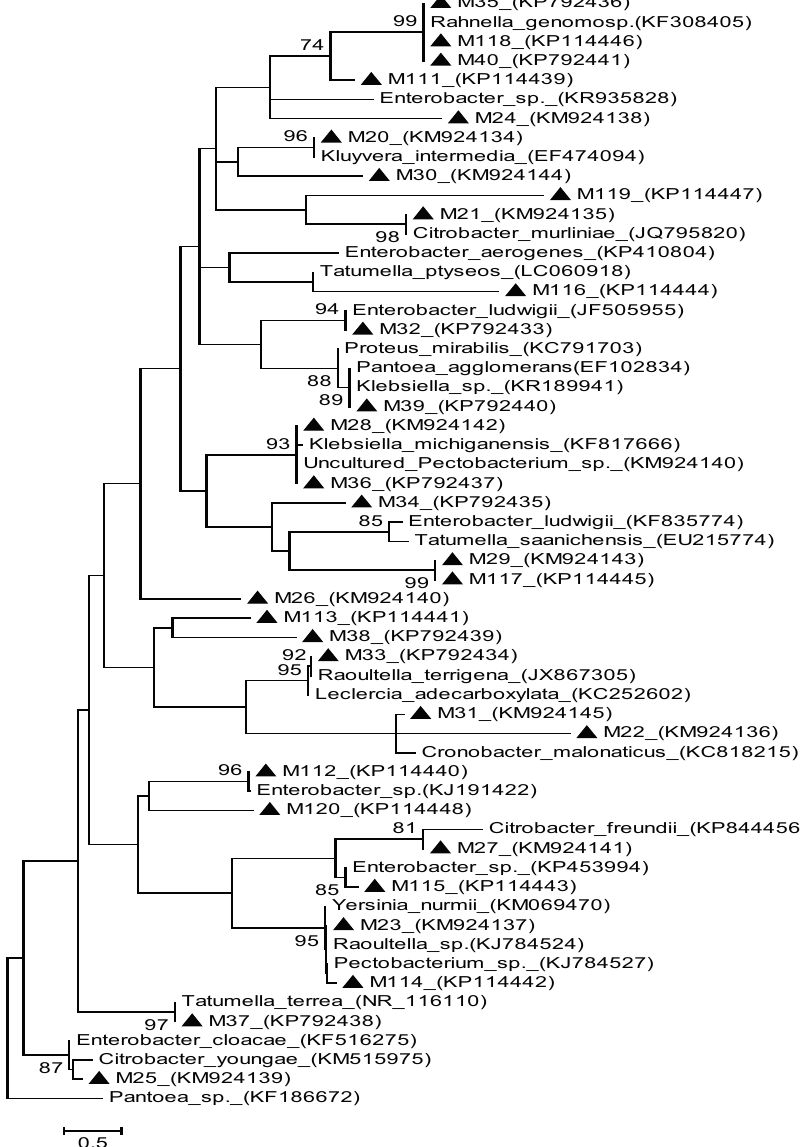
Figure 5. Maximum Likelihood phylogenetic tree based on partial 16S rDNA gene sequence, showing the phylogenetic relationships between macergens and the most closely related strains from the GenBank. Numbers at the nodes indicate the levels of bootstrap support based on 1000 resampled data sets. Only values greater than 50% are shown. The scale bar indicates 0.5 nucleotide substitution per site. Pantoea species were set as the out-group. Sequences obtained in this study are denoted with a